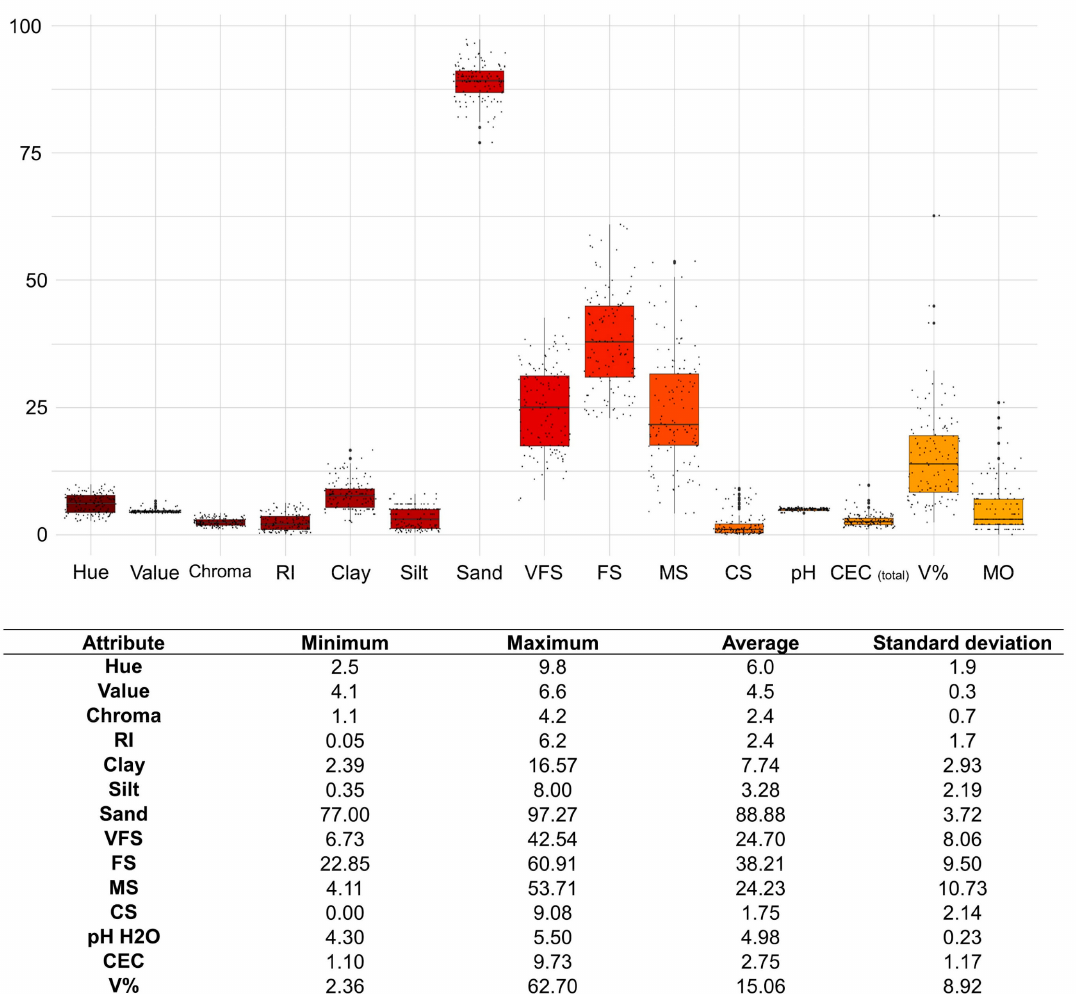
Figure 7. Distribution of soil attributes used for predictive analysis (RI, redness index; VFS, very fine sand; FS, fine sand; MS, medium sand; CS, coarse sand; V%, base saturation; OM, organic matter; textural fractions are expressed as percentage %; total CTC in Cmol c kg − 1 ; and OM in g kg − 1 ). The results highlighted the high potential of sensors to characterize and differenti- ate sandy soils regarding the sand fractions proportions. For AMF, the best model was VNS + MIR, with R 2 , RMSE, and RPIQ values of 0.84, 8.72%, and 3.49 for calibration and 0.78, 11.28%, and 3.10 for validation, respectively (Table 1). For AF, the best model was VNS and R 2 , RMSE, and RPIQ values of 0.98, 2.09%, and 11.33 for calibration and 0.65, 8.44%, and 2.31 for validation, respectively. For AM and AG, the best models were the